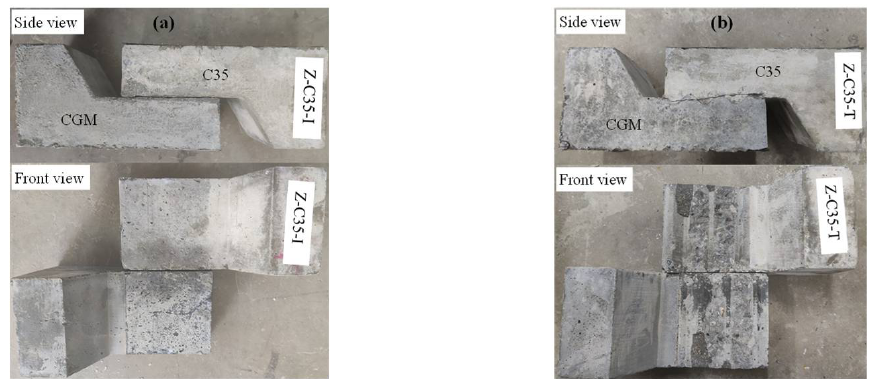
Figure 4. Cell for direct shear test.